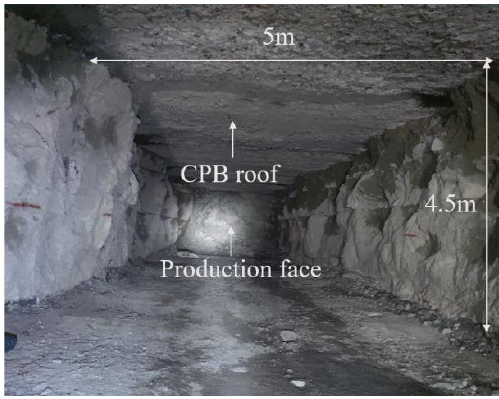
Figure 1. Drift-type stope.